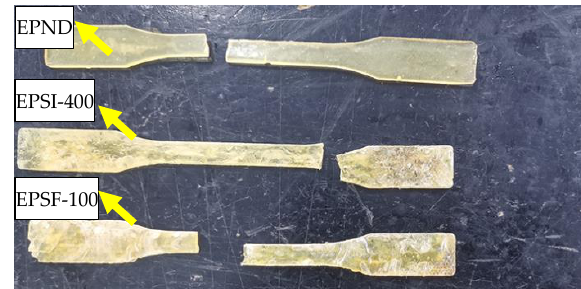
Figure 14. Failure mode of epoxy resin.